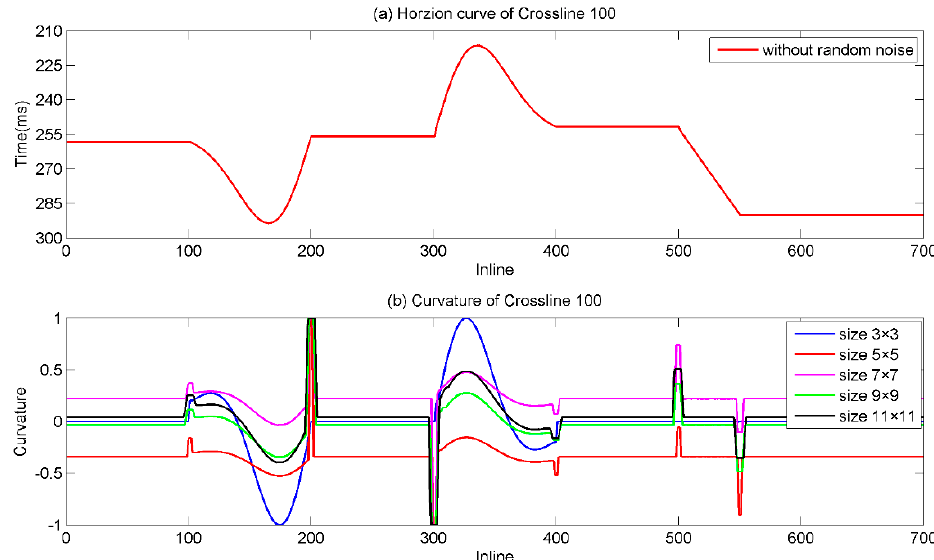
Figure 4. Horizon curve and mean curvature attribute without noise: ( a ) Horizon curve and ( b ) mean curvature attribute of different time windows without noise. Table 1. Correlation coefficient for different time windows without noise.